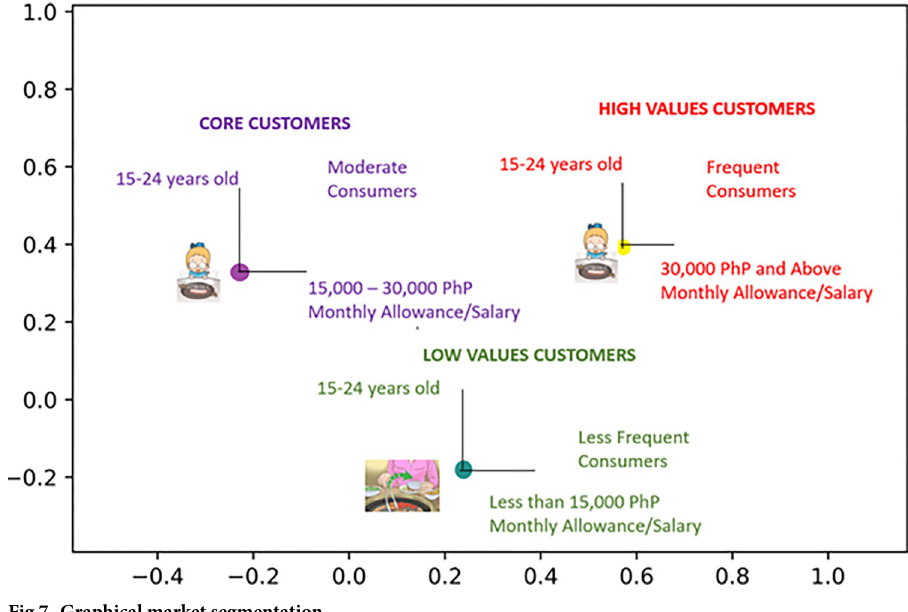
Fig 7. Graphical market